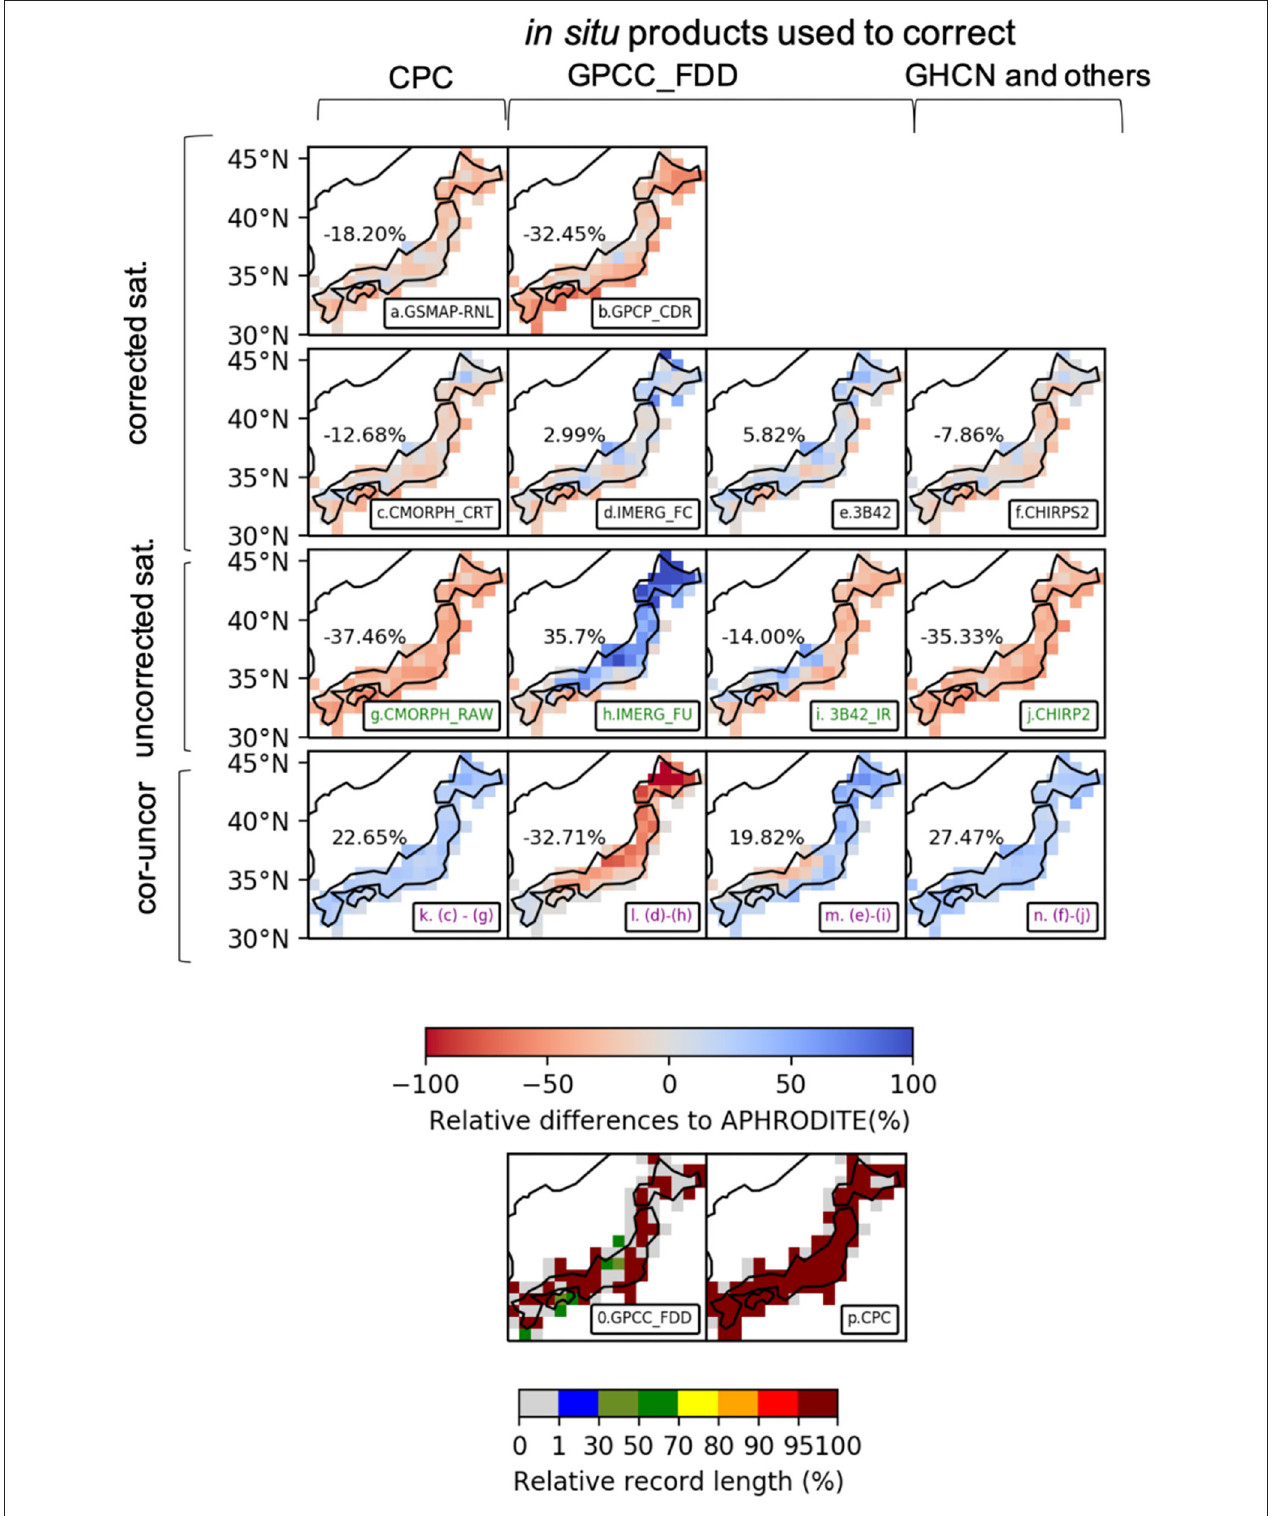
FIGURE 5 | Upper panel: relative difference to APHRODITE (in %) of the climatological (over the period of 2001–2013) annual wettest day (Rx1day) for corrected satellite products (black labels, two upper rows): (a) GSMAP_RNL, (b) GPCP_CDR, (c) CMORPH_CRT, (d) IMERG_FC, (e) 3B42, (f) CHIRPS2; uncorrected